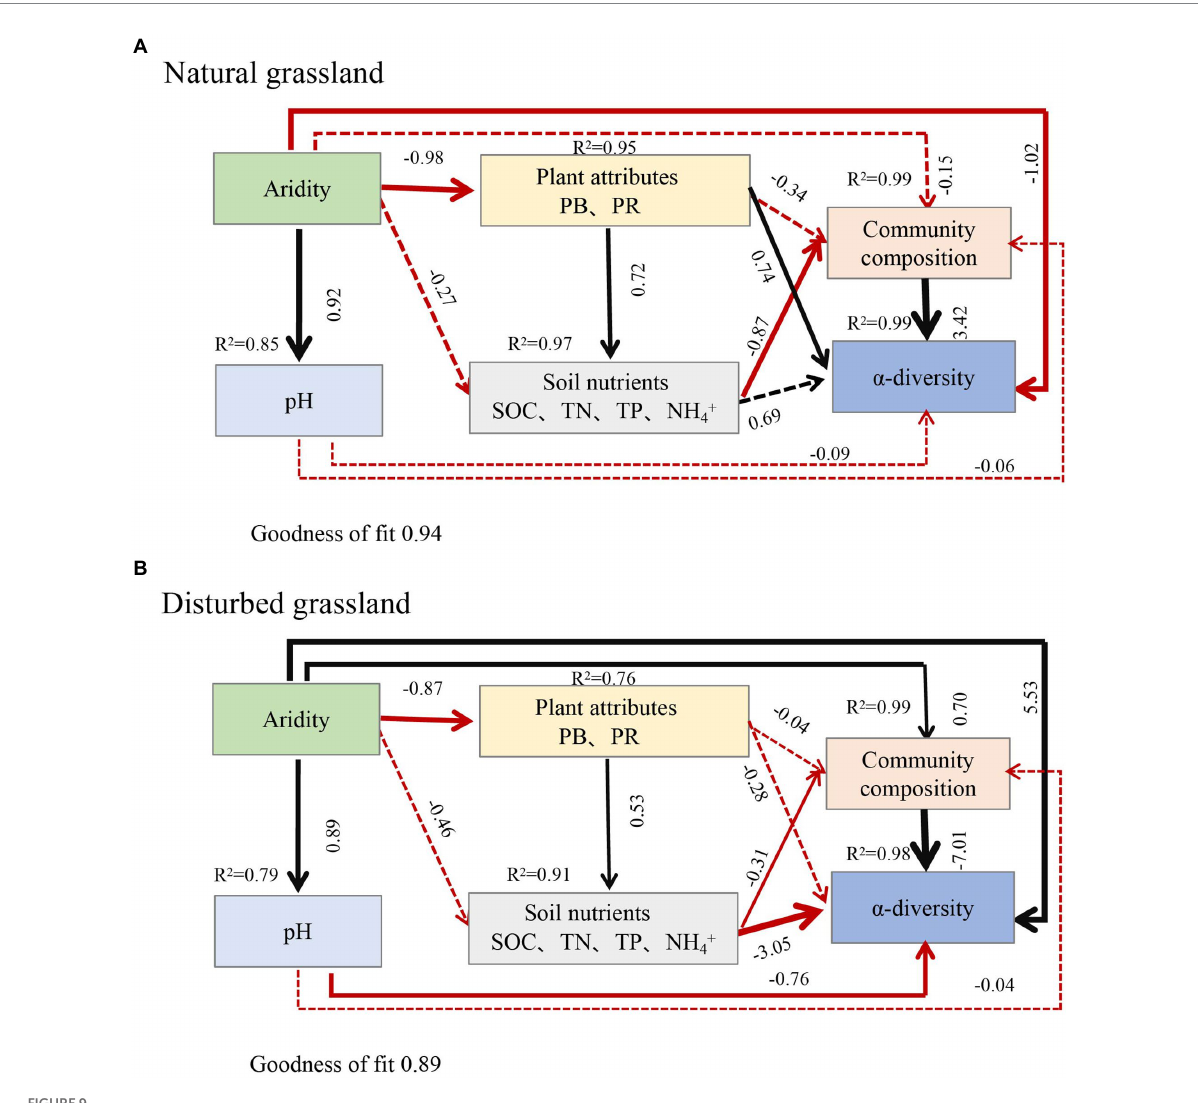
FIGURE 9 Partial least squares path modelling (PLS-PM) disentangling the direct and indirect influence of aridity on the composition and α -diversity of soil pqqC community in natural grassland (A) and disturbed grassland (B) . Black arrows and red arrows denote significantly positive and negative relationships, respectively. Solid and dashed arrows represent significant and non-significant paths, respectively. Number above each arrow represents standardized path coefficients (the effect size of the relationship). The width of the arrows indicates the strength of the standardized path coefficient. R 2 indicates the variance of dependent variable explained by the model. PB, plant biomass; PR, plant richness; SOC, soil organic carbon; TN, total nitrogen; TP, total